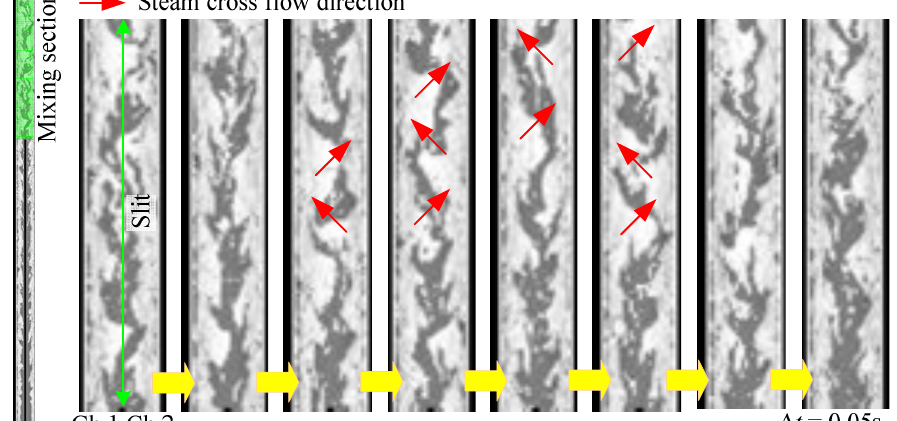
Fig.8 Calculated slug behavior of case 3-5 in mixing